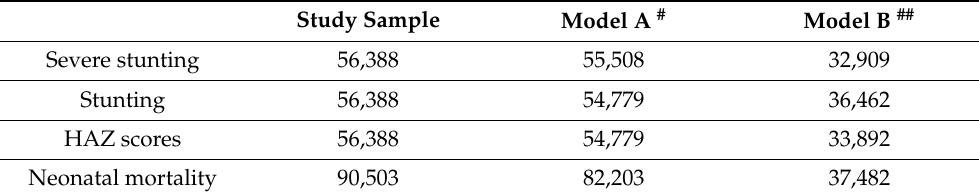
Table 1. Sample size of the final models.